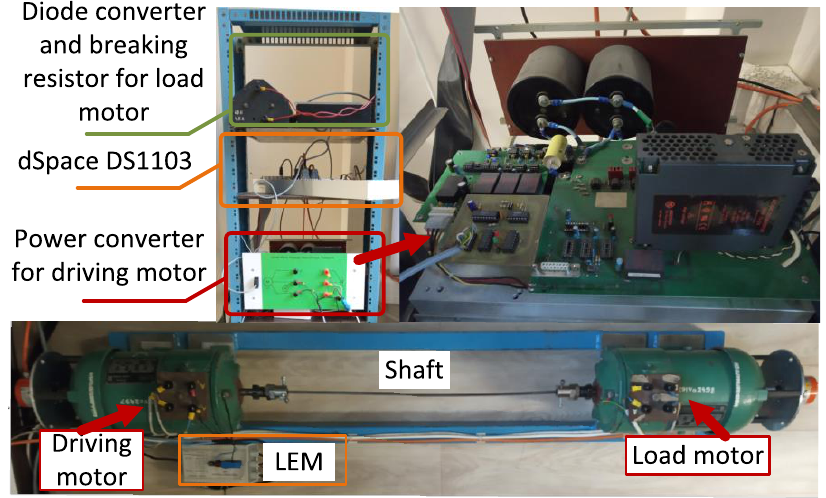
Figure 9. Picture of laboratory set-up.